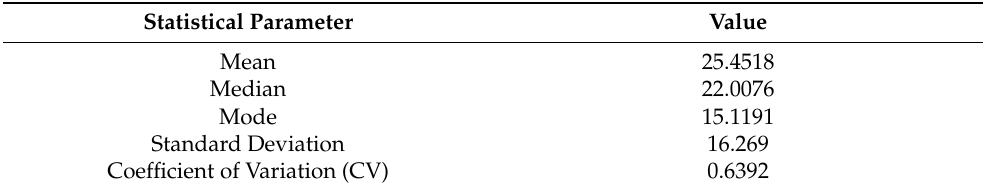
Table 3. Statistical metrics for % improvement in retail supply chain performance.